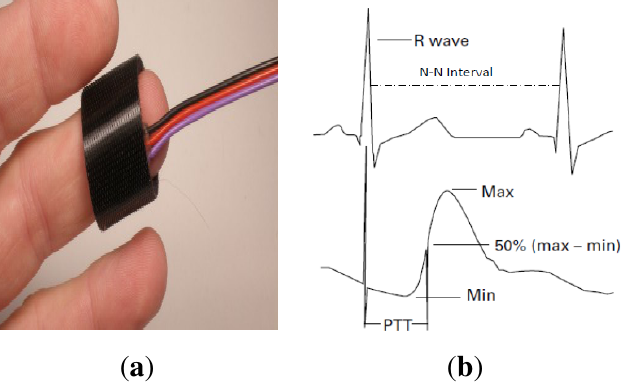
Figure 4. Heart rate prototype: ( a ) the photoplethysmographic sensor located on the patient’s finger and ( b ) an example of an ECG curve showing how to identify the R wave and the N-N